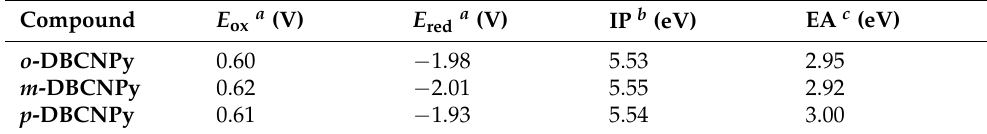
Table 3. Electrochemical data of the isomers.